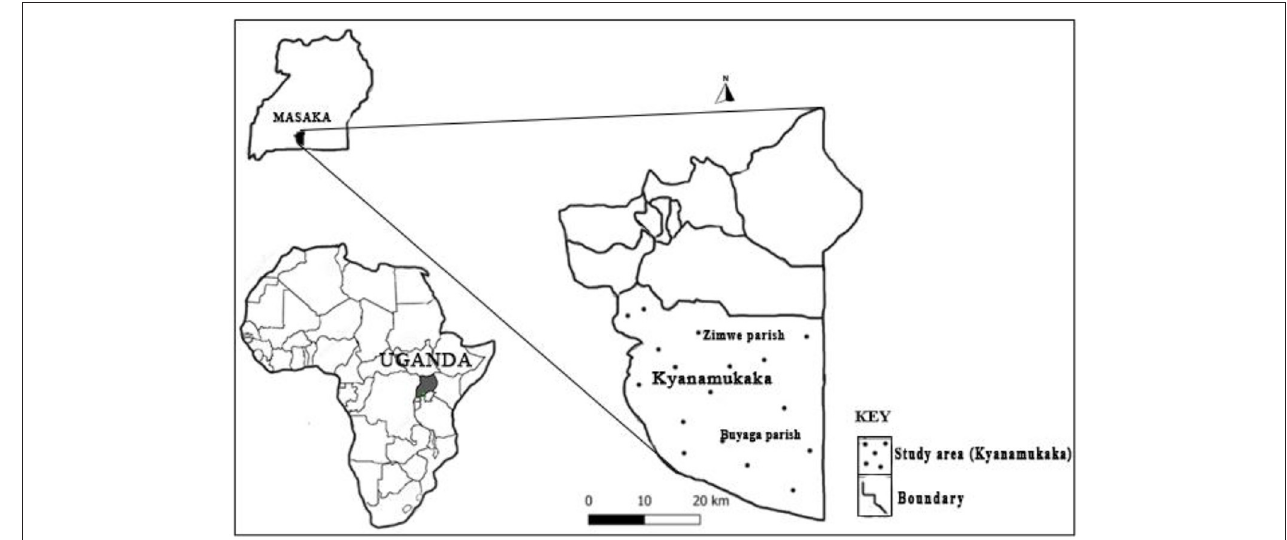
FIGURE 1 | A map of Masaka district showing the study area (Kyanamukaka